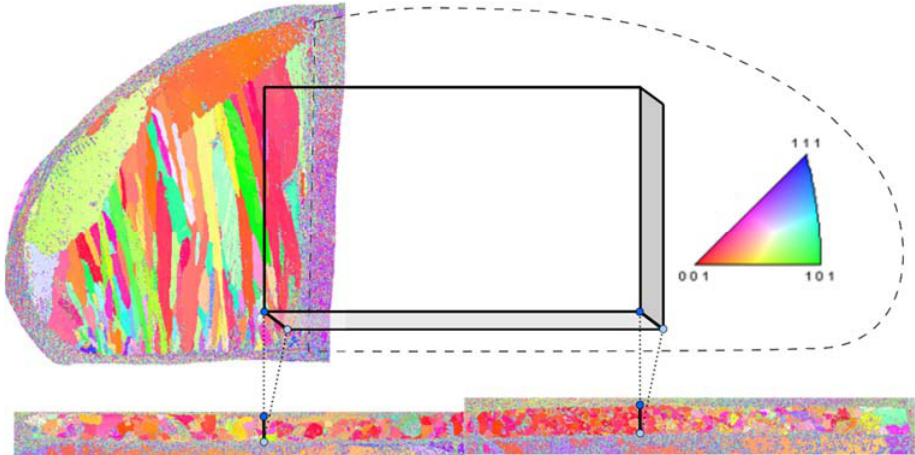
Figure 2. Columnar growth in arc-melted samples. The EBSD method demonstrates strong [001] tex- ture. The sample for magnetic measurement was cut as shown. The bottom part shows predominant [001] orientation of the grains and its relation to the sample. The sample size is sketched and scaled proportionally to the EBSD